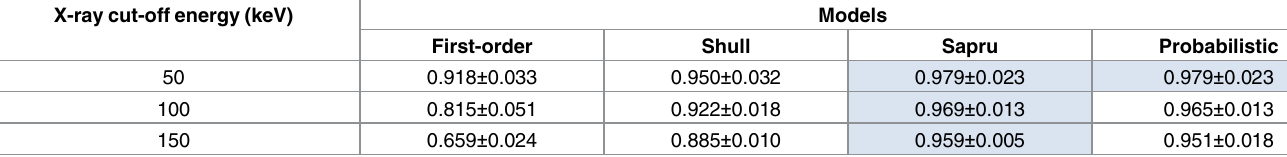
Table 1. Goodness of fit (R 2 ) values for the four models based on averageddata.